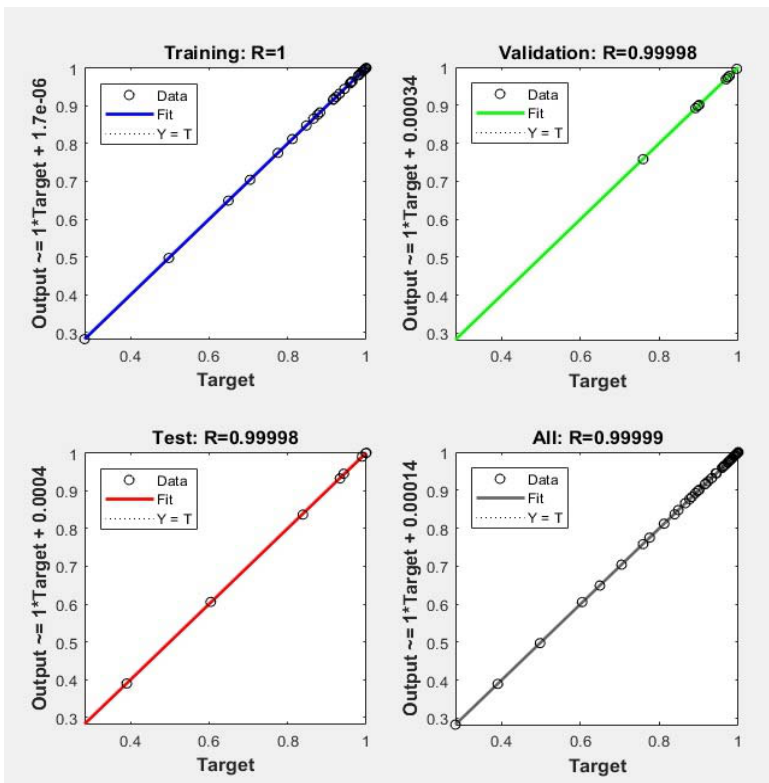
Figure 6. Regression results of training, validation, test, and all.